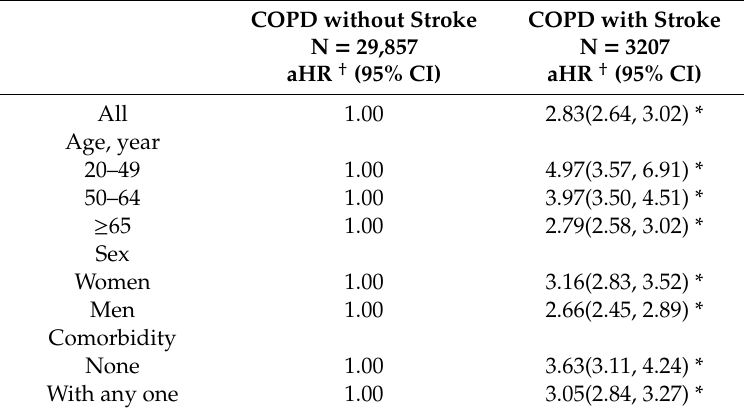
Table 3. Incidence and hazard ratio of mortality stratified by age, sex, and comorbidity in patients who had COPD with stroke compared with those who did not have stroke. COPD with Stroke COPD without Stroke N = 3207 N = 29,857 aHR † (95% CI) aHR † (95% CI) All 1.00